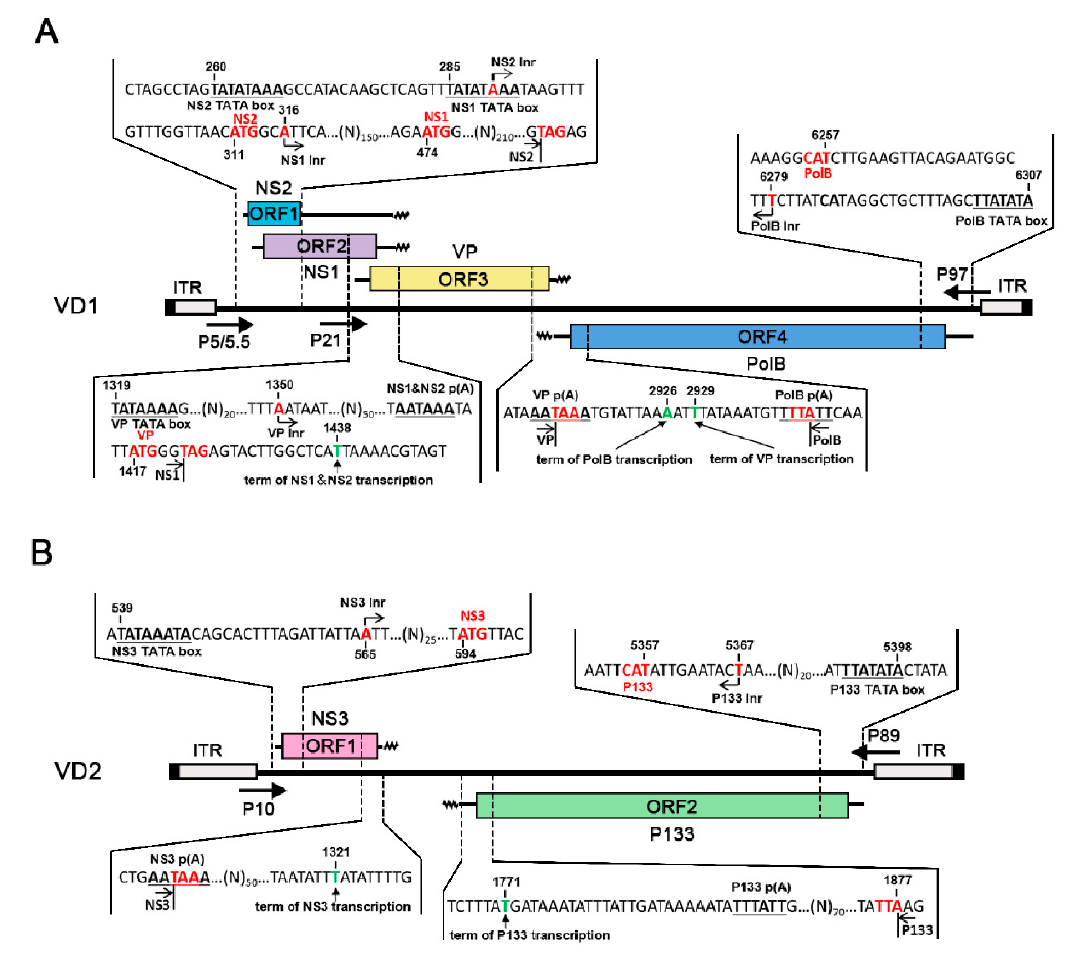
Figure 2. Mapping of 5 (cid:48) and 3 (cid:48) ends of Bombyx mori bidensovirus (BmBDV) transcripts: ( A ) mapping of 5 (cid:48) and 3 (cid:48) ends of VD1, ( B ) mapping of 5 (cid:48) and 3 (cid:48) ends of VD2. The bars with inverted terminal repeats (ITRs) at both ends represent the BmBDV genome. Major open reading frames (ORFs) that encode proteins are shown as boxes, whereas mRNA transcripts are indicated in the middle. The wavy lines indicate polyA tails. The arrows indicate the position of the VD1 and VD2